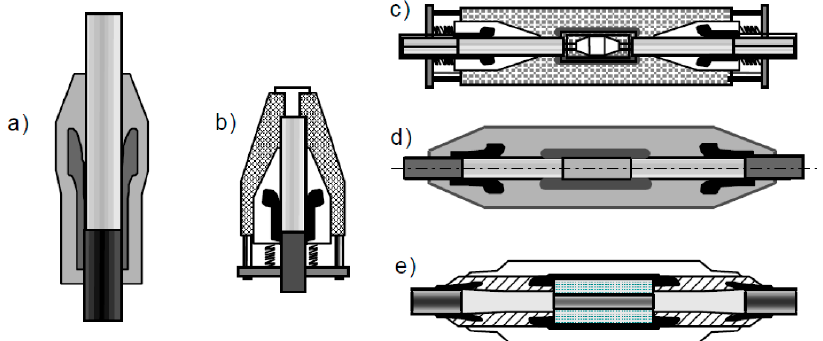
Figure 1. Prefabricated cable accessories for high voltage extruded cables have the following forms: ( a ) one-piece termination; ( b ) composite termination; ( c ) composite joint; ( d ) one-piece joint; ( e ) three-